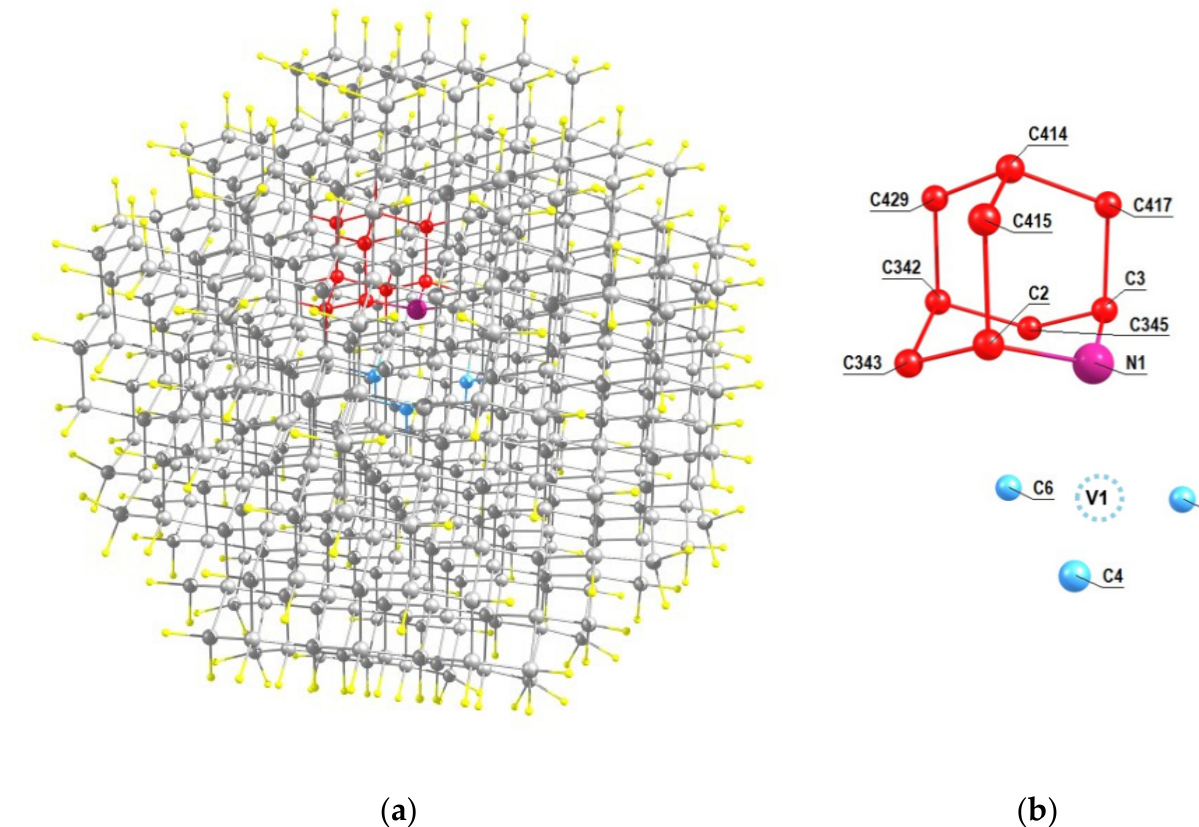
Figure 3. ( a ) Location of the 2-aza-adamantante seed in the C 510 [NV]-H 252 cluster of the work [33] at the NV1 orientation of the formed NV center and ( b ) the numeration of the carbon atoms of the seed (shown in red) in the cluster. Nearest neighbors of the vacancy V1 of the center are shown in light blue.